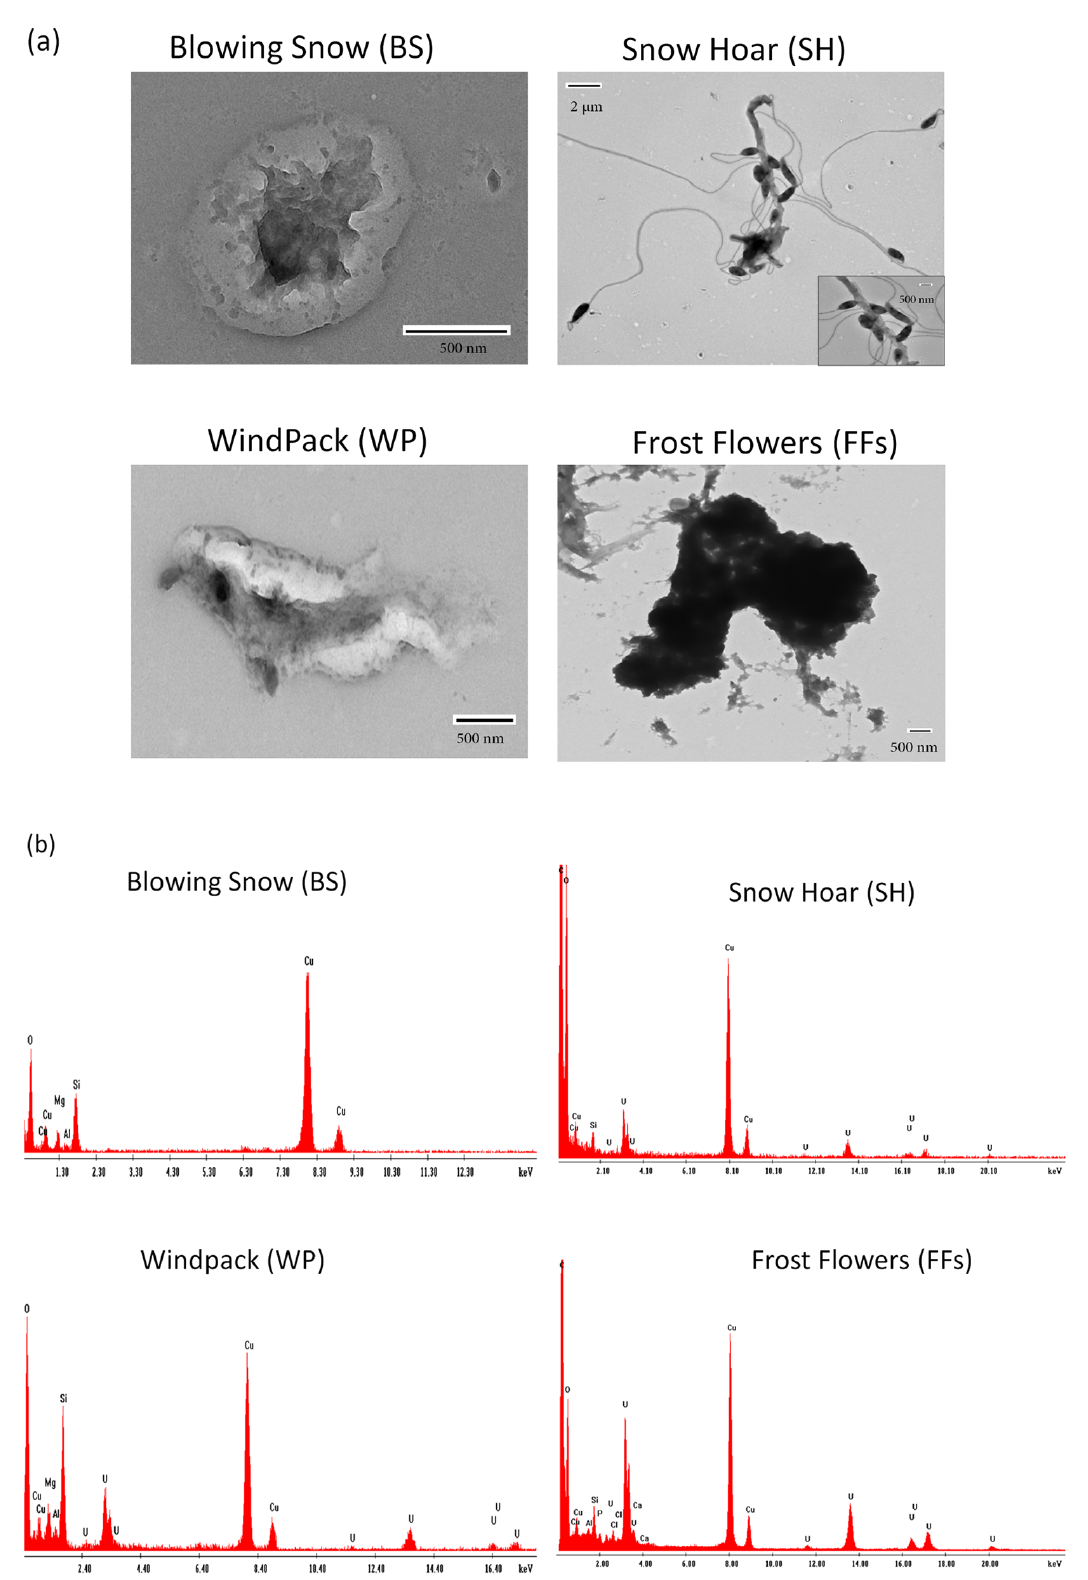
Figure 1. Analysis of snow-associated microorganisms by transmission electron microscopy (TEM) in conjunction with energy-dispersive X-ray spectroscopy (EDS). Microorganisms (a) and chemicals (b) were detected in selected Arctic samples: blowing snow, BS; surface hoar snow, SH; windpack, WP, and frost flowers,